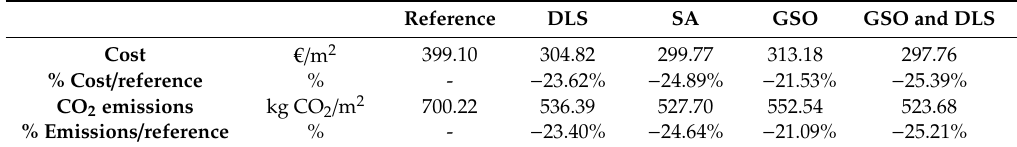
Table 6. CO 2 emissions and cost data comparison from the reference solution and the heuristics.